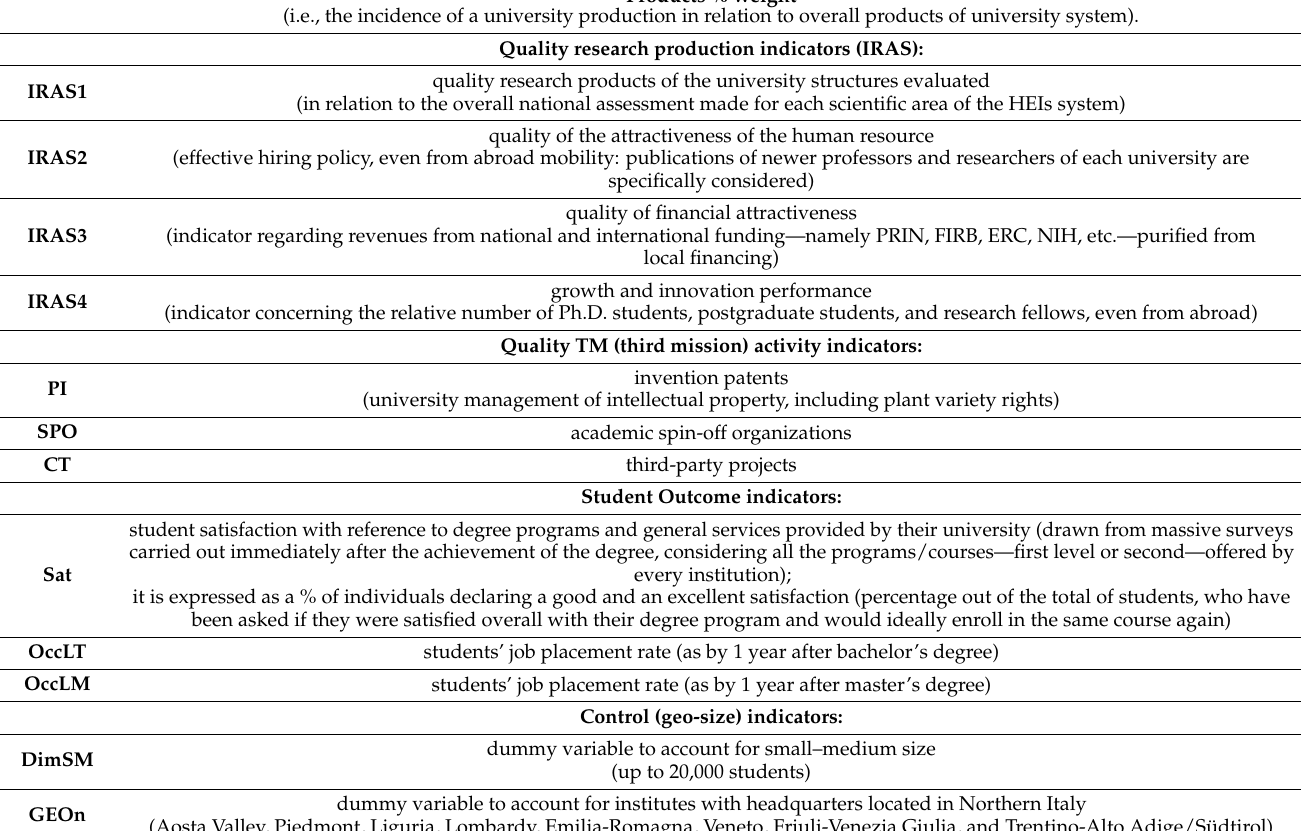
Table 1. Mission-related